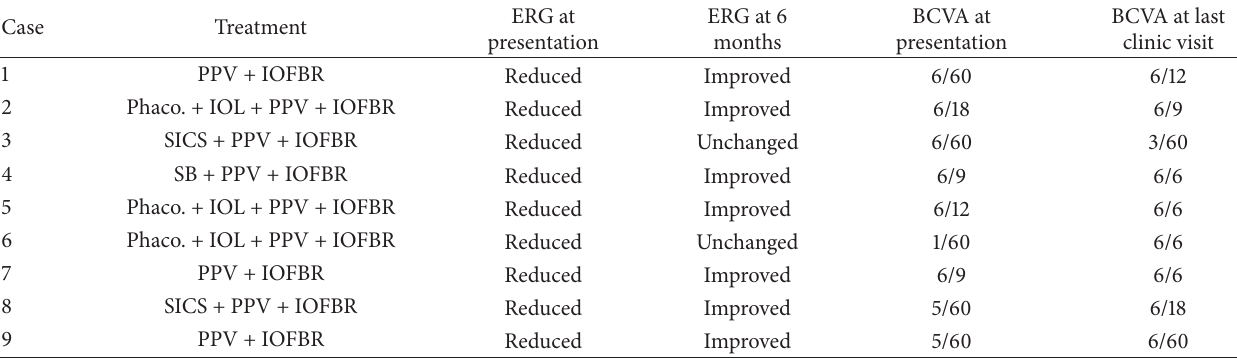
Table 2: Treatment, ERG changes, and visual outcome.